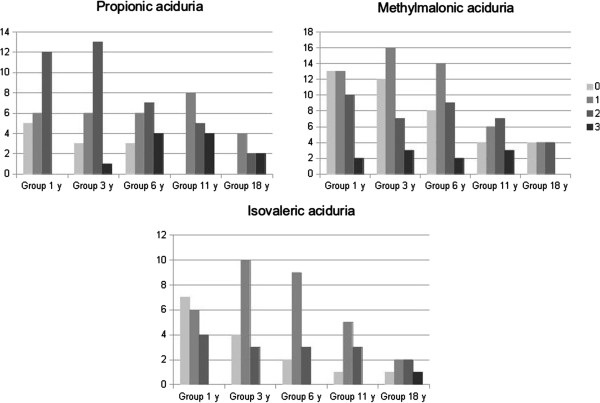
PA, MMA and IVA patients repartition according to psychometric tests at different ages (normal 0–1, intellectual deficiency 2–3).